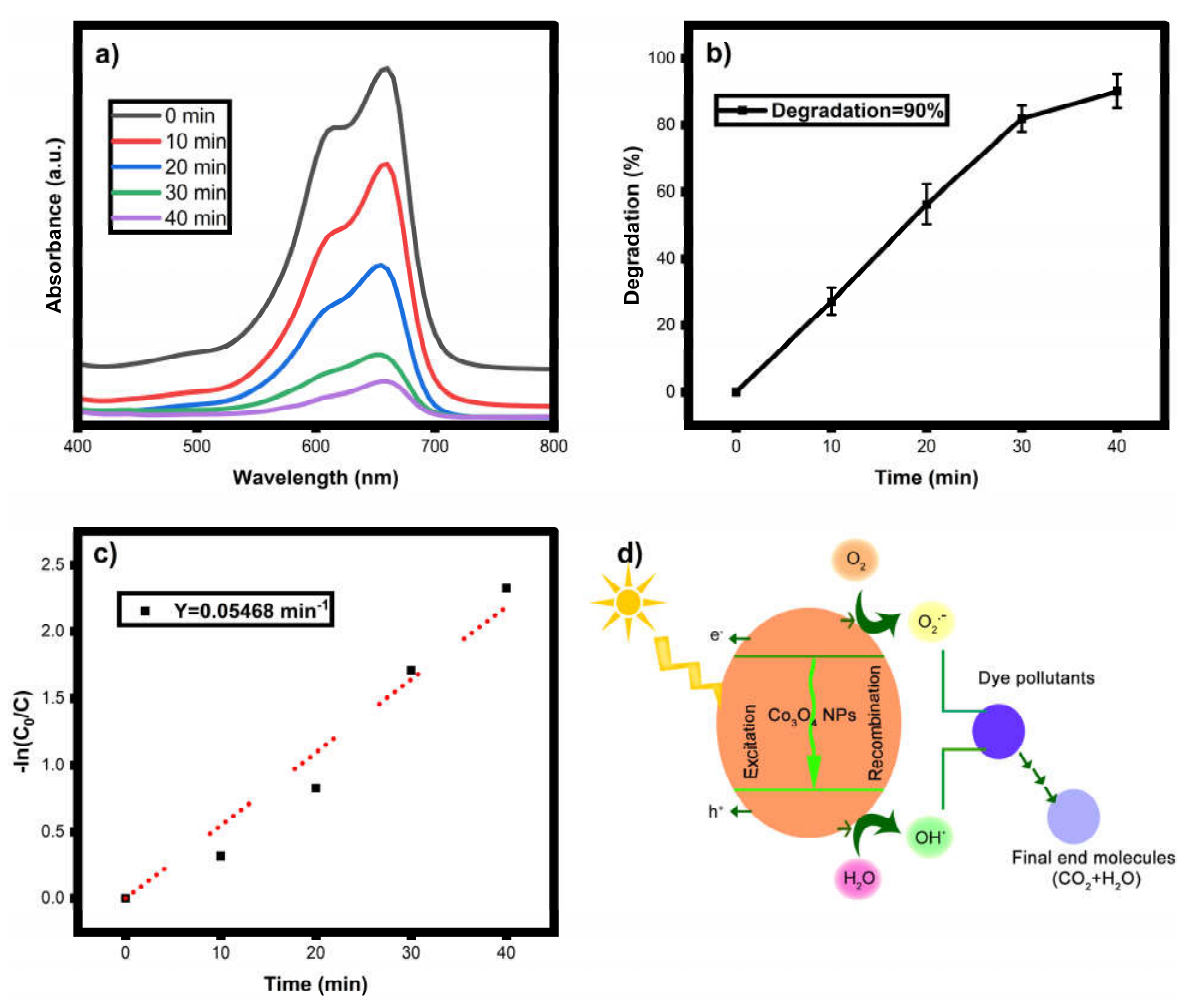
Figure 7. ( a ) Visible light MB dye degradation spectrum, ( b ) Degradation efficiency, ( c ) kinetic rate and ( d ) Photocatalytic dye degradation mechanism of Co 3 O 4 nanoparticles.